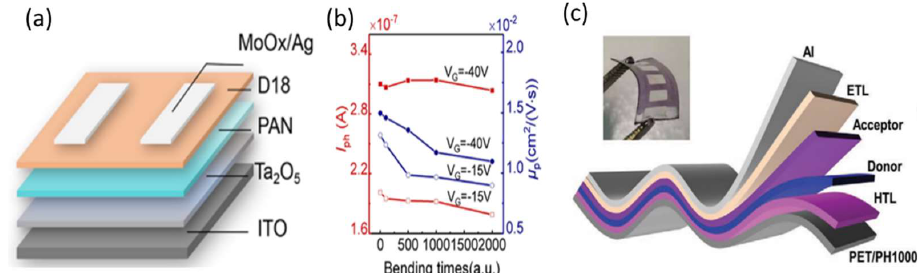
Figure 3. ( a ) Schematic illustration of the D18-based OFETs, ( b ) flexibility test (V DS = −40 V) of the D18-based flexible OPTs, showing how the device mobility and the photocurrent changes under 2000 bending cycles, reprinted with permission from [45] ©2021 ACS Publications . And ( c ) Device structure of flexible SD device, reprinted with permission from [41] ©2021 Wiley .